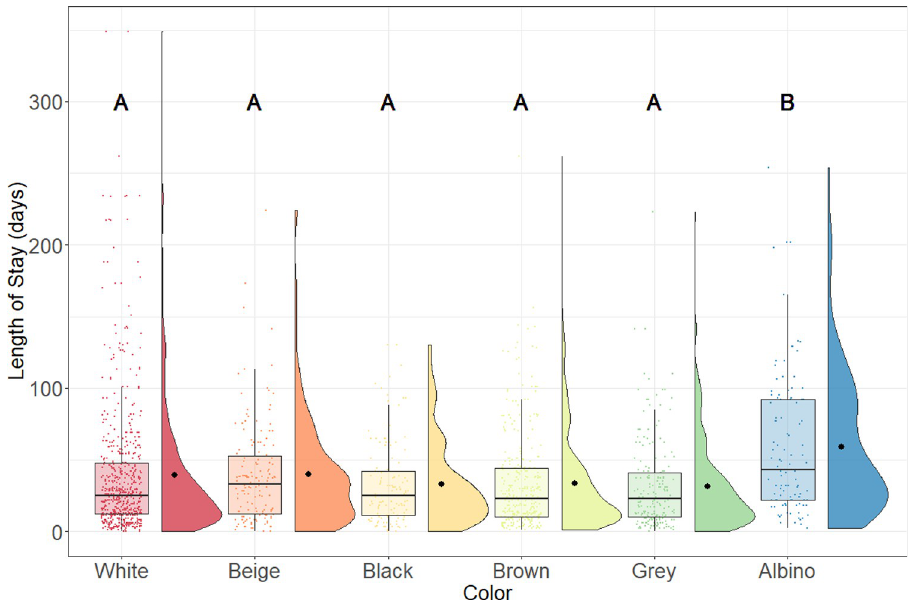
Fig 6. LOS of adopted rats by colour. Boxplots represent the median, the 25 and 75 percentiles, with whiskers representing the 95 percentiles. Individual data is shown by dots on the boxplot. Additionally, the rain cloud plots show the distribution and the means in each